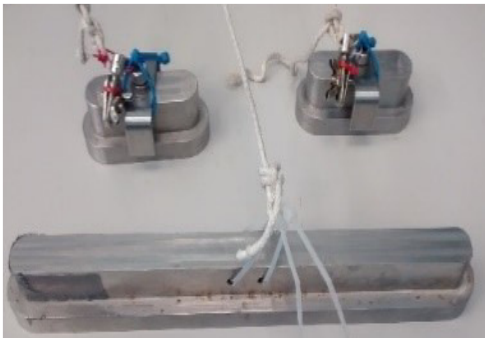
Figure 12. Loads (Perturbation).